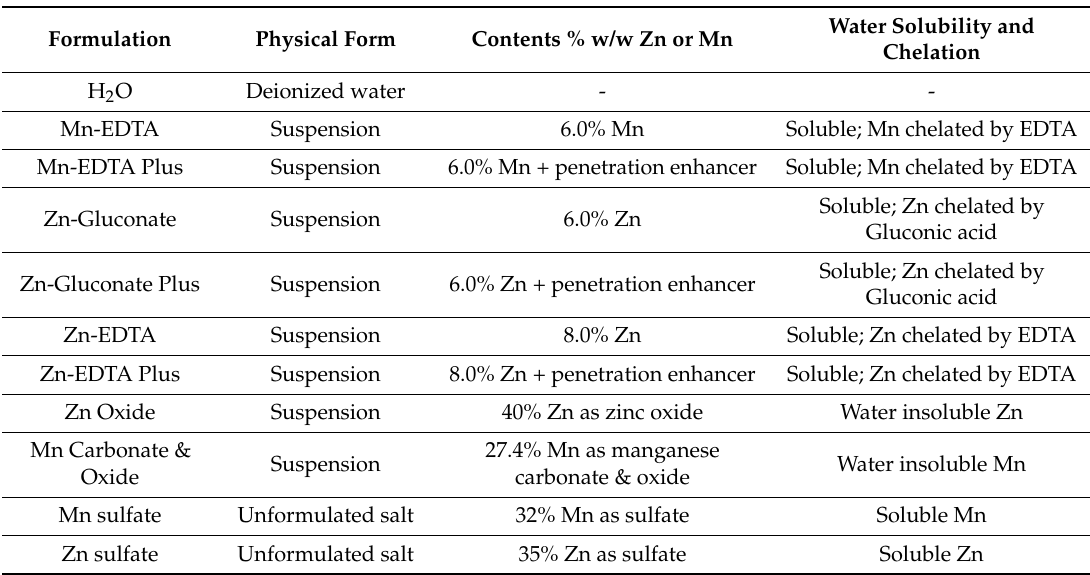
Table 1. Overview of the Mn and Zn formulations used in the experiments; deionized water served as the control